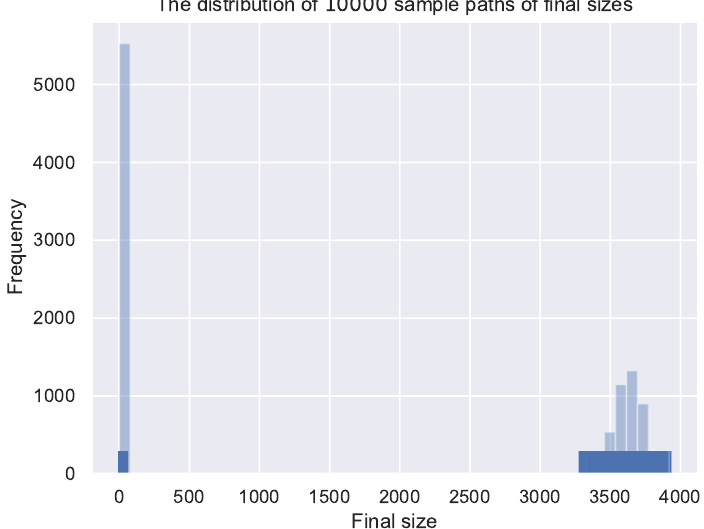
Figure 6. The distribution of the final sizes of 10 4 realizations for the CTMC model (3) with one exposed stage (simulated with SSA).